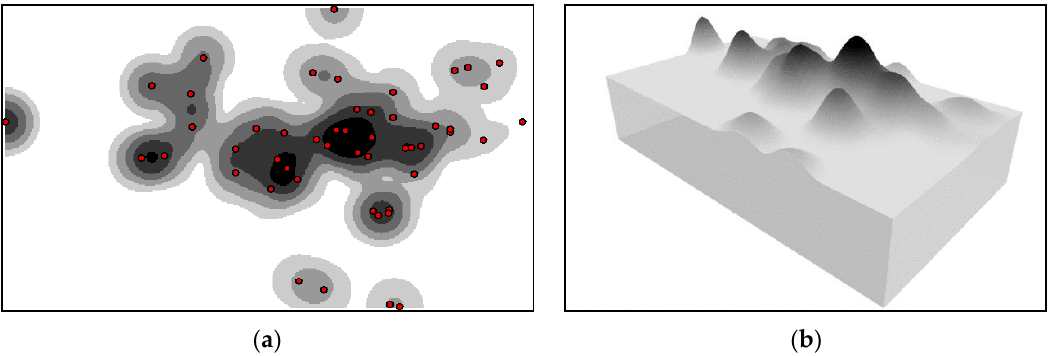
Figure 4. Interpolation results of kernel density estimation interpolation: ( a ) two-dimensional result; ( b ) three-dimensional result.